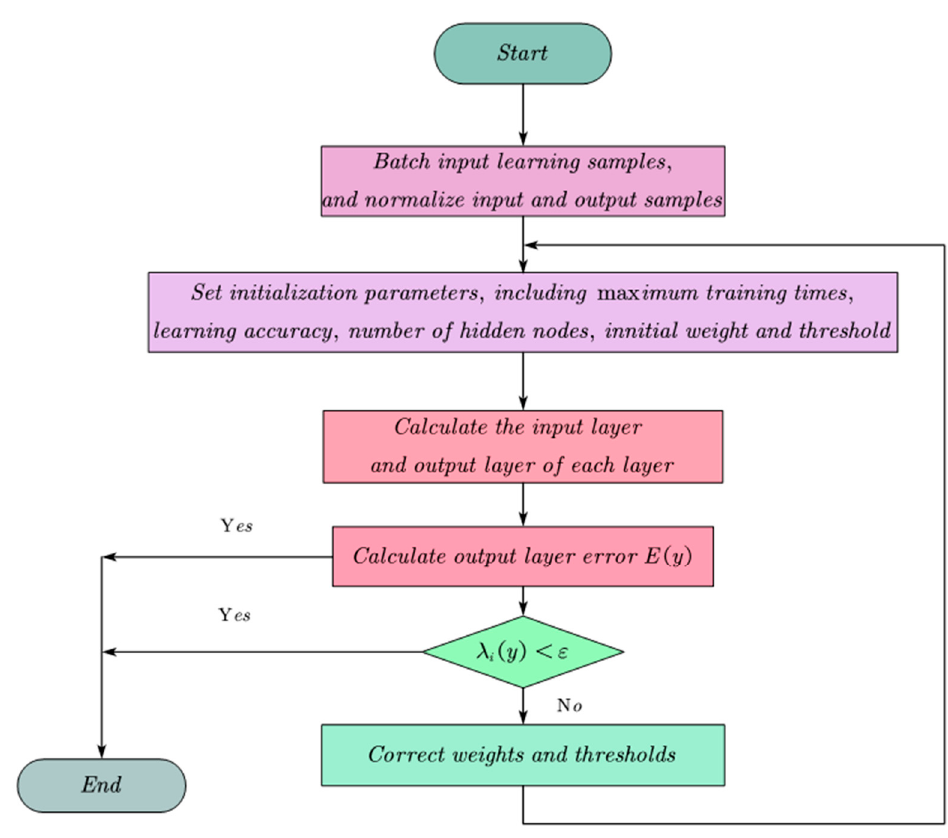
Figure 2. A flow chart of Levenberg–Marquardt algorithm.